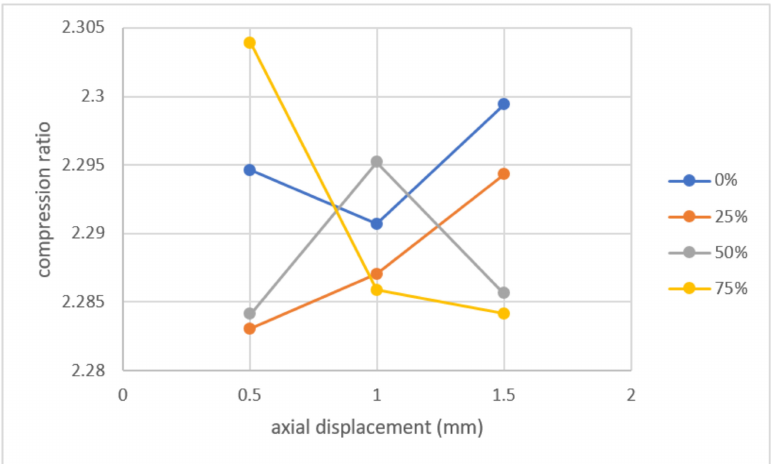
Figure A1. Compression Ratio as a function of gap and